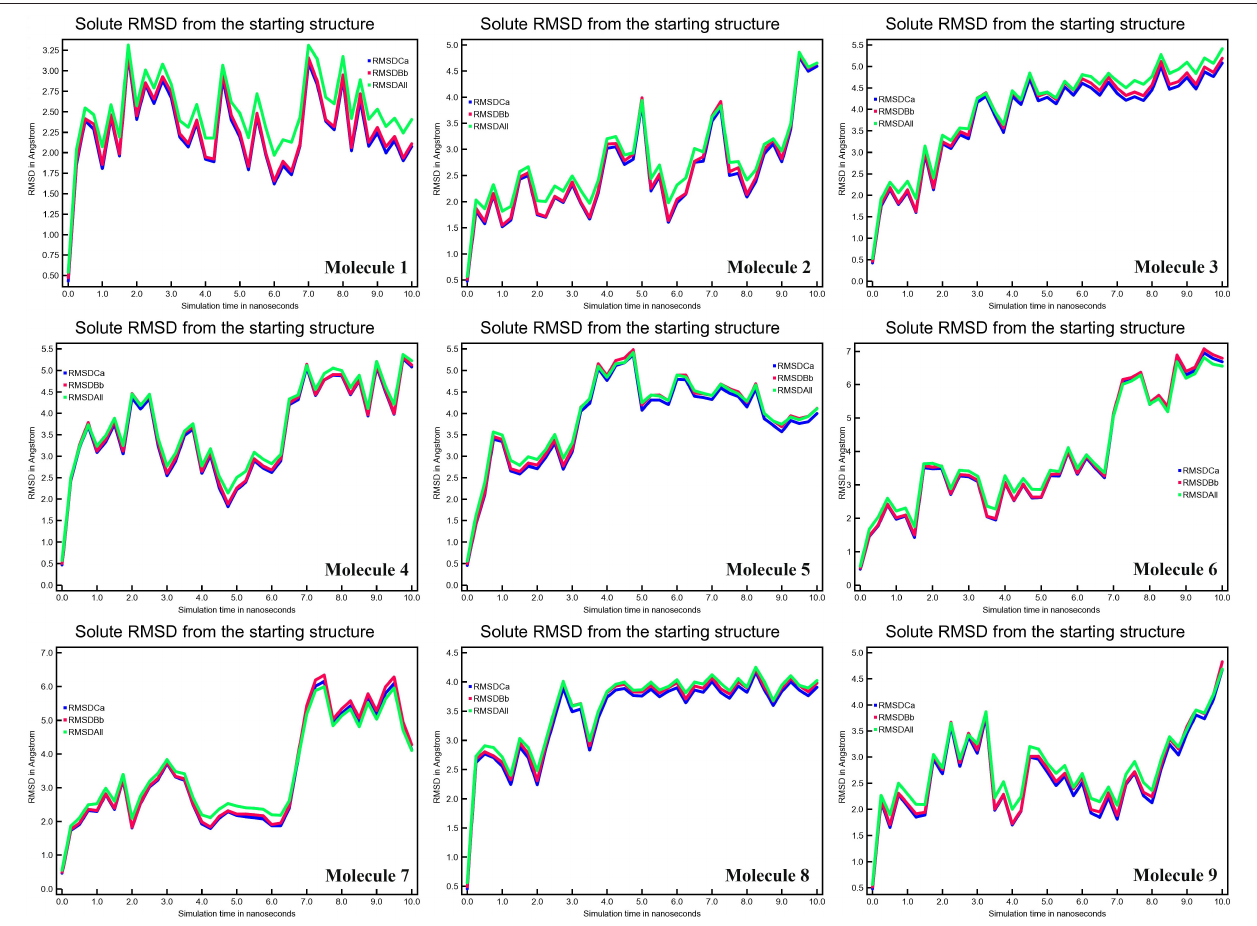
FIGURE 4 | Calculations of RMSD of CYP51 and nine molecules as a function of 10 ns simulation time.